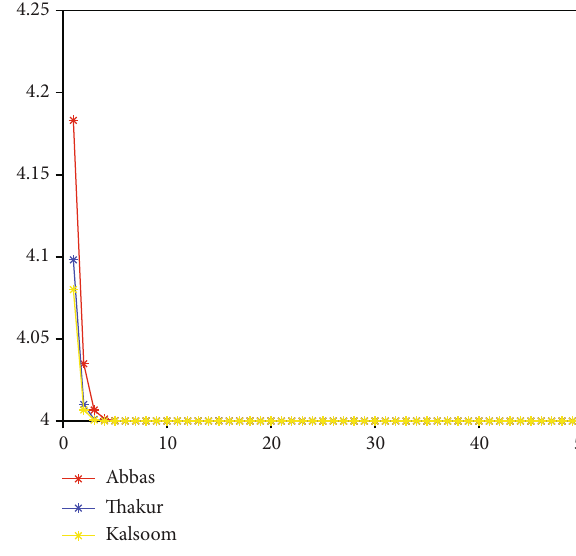
Figure 6: Convergence behavior of Abbas, Thakur, and Kalsoom et al. iterations towards fi xed